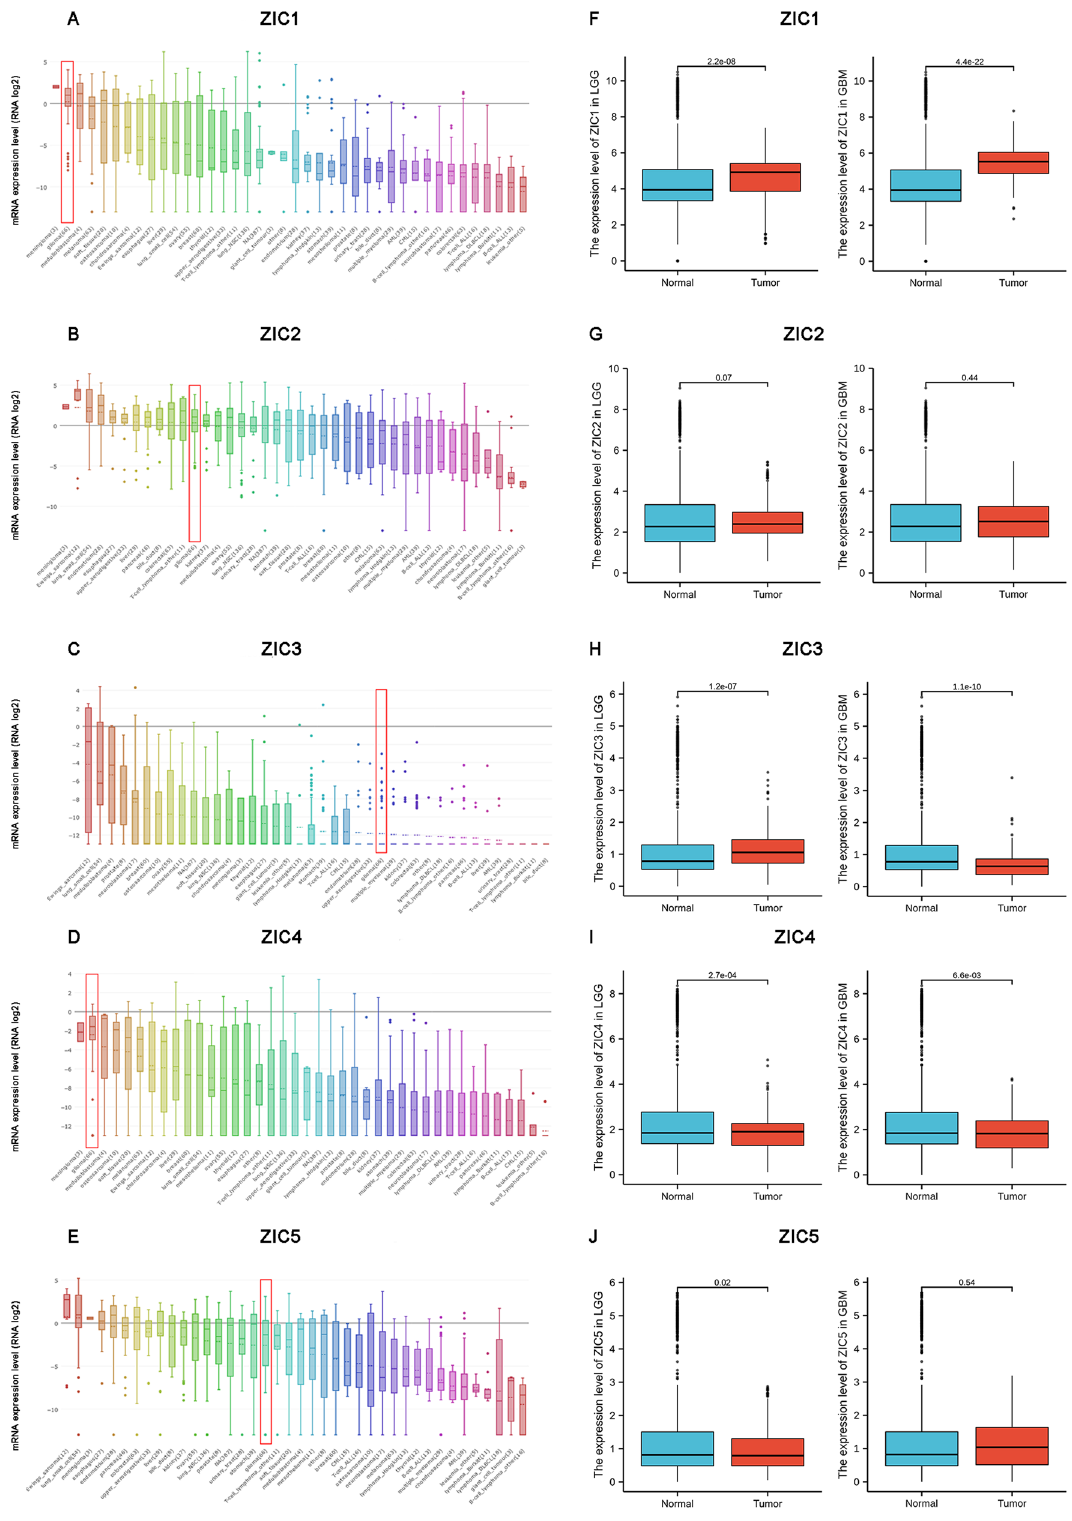
Figure 1. Transcriptional expression of ZICs in various types of cancer. ( A – E ) ZIC expression patterns in 1457 cell lines representing 40 distinct tumour types (CCLE). ( F – J ) mRNA expression of distinct ZIC family members in LGG tissues and adjacent normal brain tissues